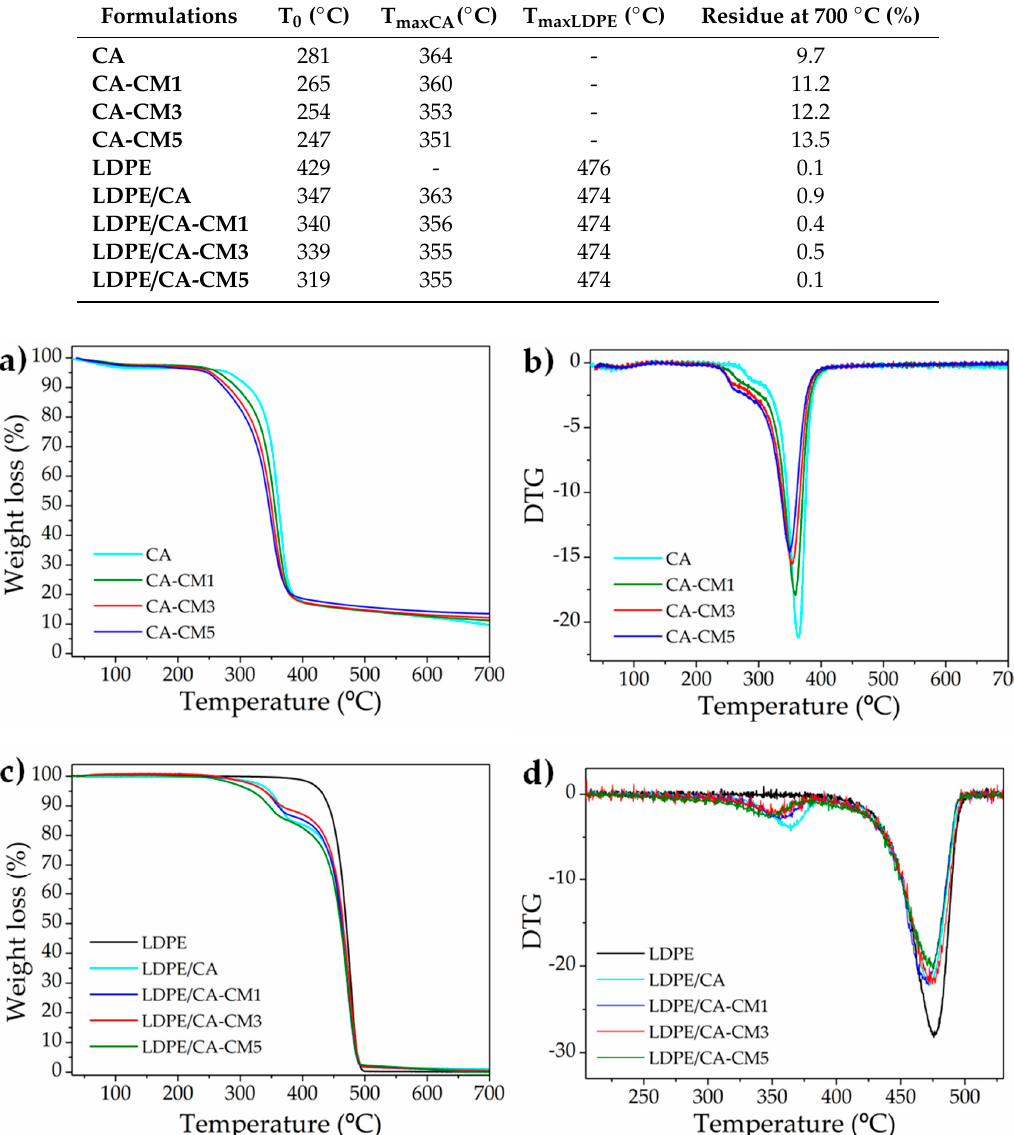
Table 3. TGA thermal properties of CA-CM-based films and LDPE/CA-CM-based films.